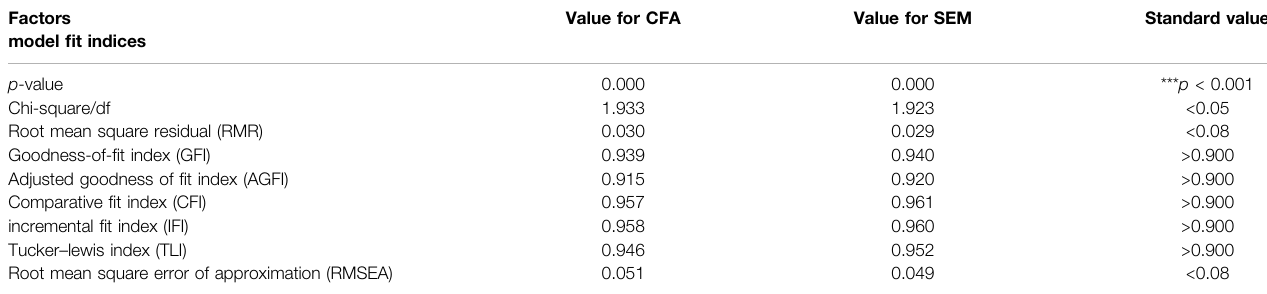
TABLE A2 | Model fi t indices for measurement and structural model of the